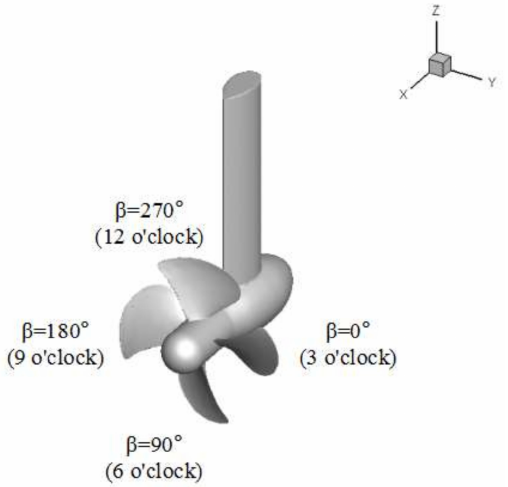
Figure 2. 3D view of the pod